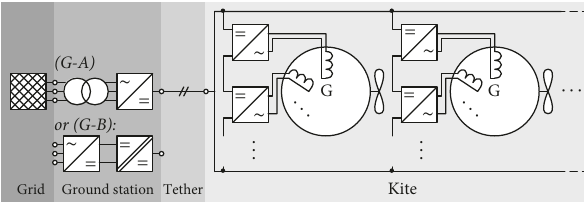
Figure 5: DC tether transmission, multiphase machines divided intosingle-phasesubmachines,andDC-seriesconnectedconverters [13]. The power converters on ground may be identical to Figure